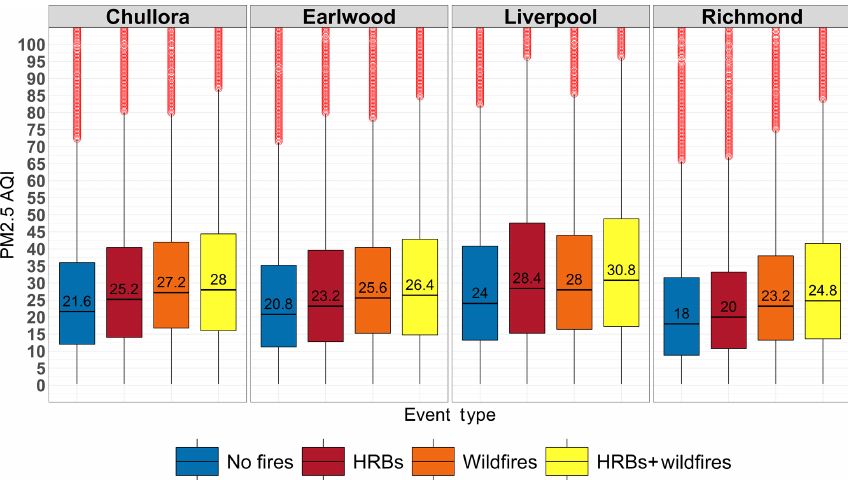
Figure 3. Box plots showing the variation in PM 2 . 5 air quality index values (AQIs) at four measurement sites in Sydney between 2011 and 2016 during days when there were no fires (neither hazard reduction burns (HRBs) or wildfires), days when only HRBs occurred without coincident wildfires, days when wildfires occurred without coincident HRBs, and days with concurrent HRBs and wildfires. Horizontal black lines on box plots are median PM 2 . 5 AQIs, and their corresponding values are shown above these lines. Red circles are outliers.